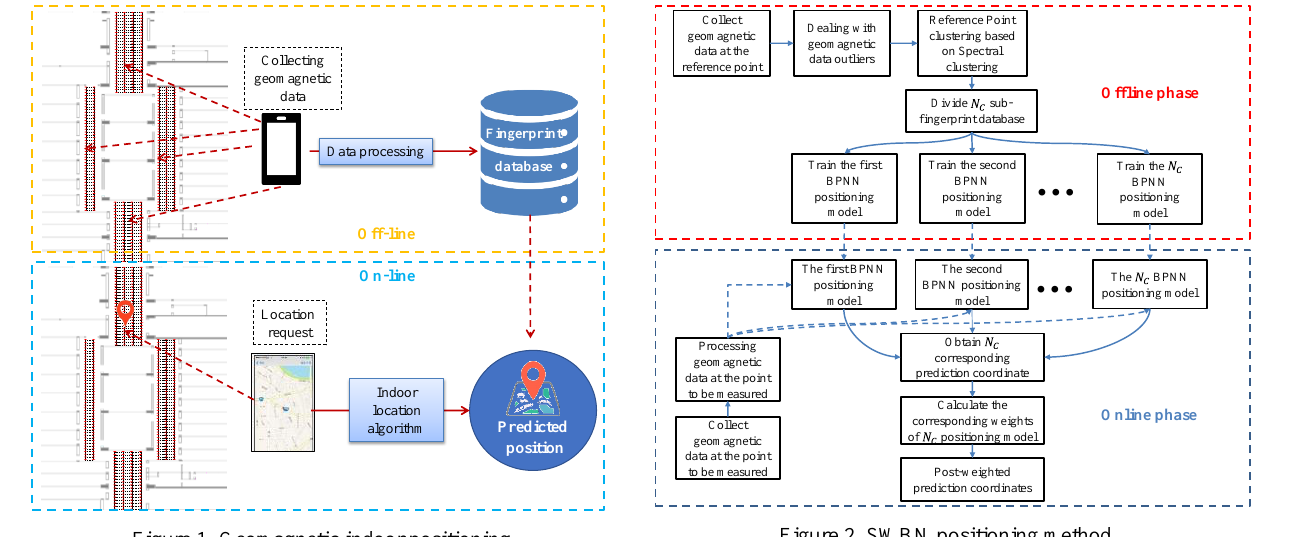
Figure 1. Geomagnetic indoor positioning Figure 2. SWBN positioning